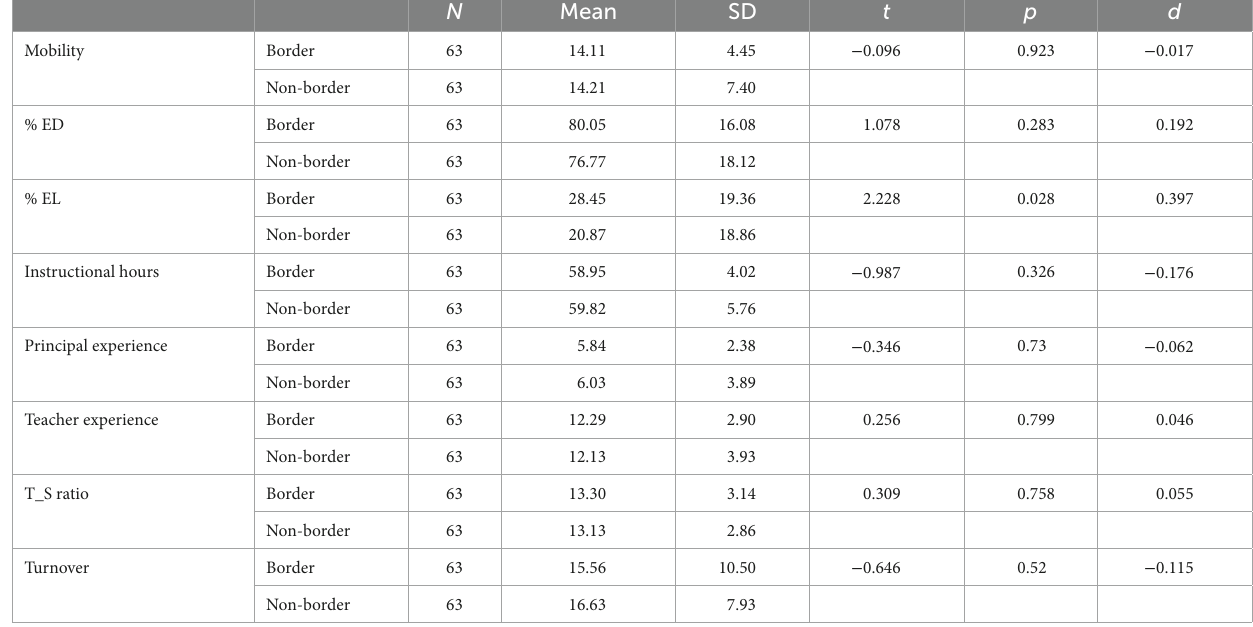
TABLE 1 The t -test results from comparing border and non-border school districts’ demographic characteristics.